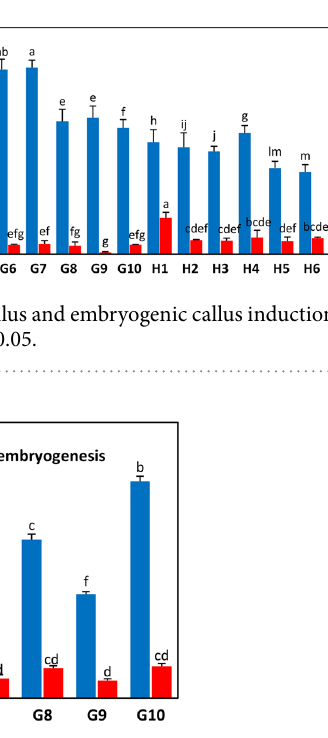
Figure 8. Effect of mother tree genotype on the frequency of adventitious bud formation and somatic embryogenesis. Duncan's new multiple range test was used to detect differences at P <